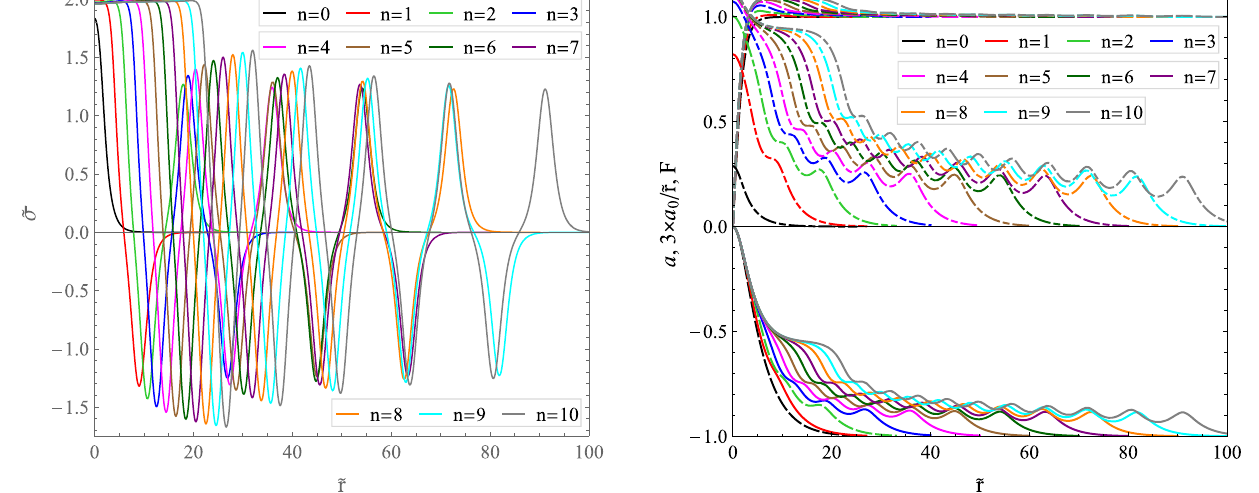
Fig. 10 Ansatz functions a , 3 a 0 / ˜ r , and F for the first 10 radially